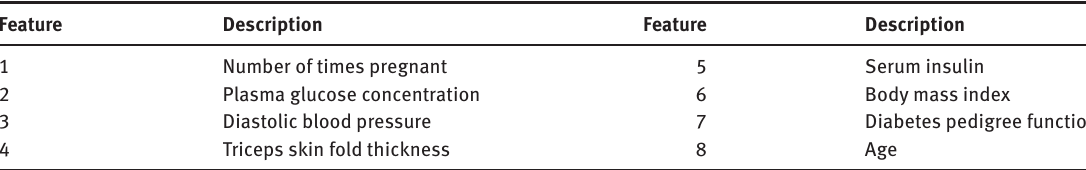
Table 1: PID dataset attribute description.